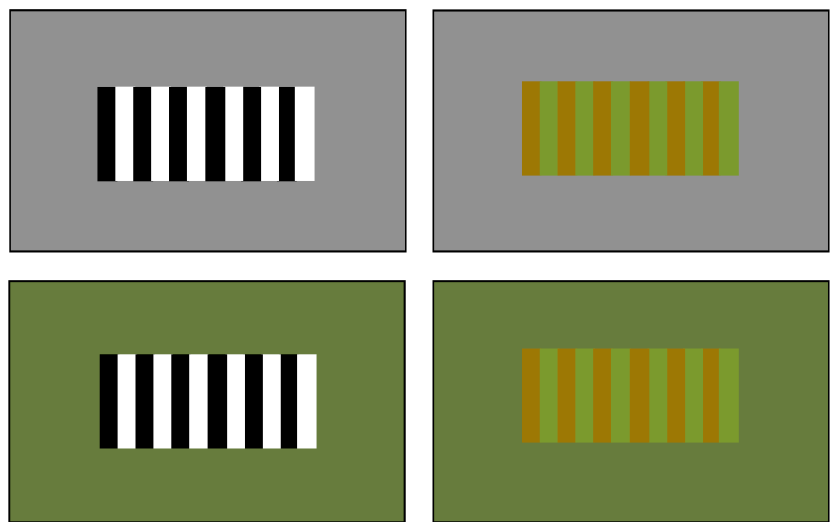
Fig 7. Colour combinations for Experiment 6. Each combination was tested for the moving ‘ with ’ and moving ‘ against ’ directions, producing eight